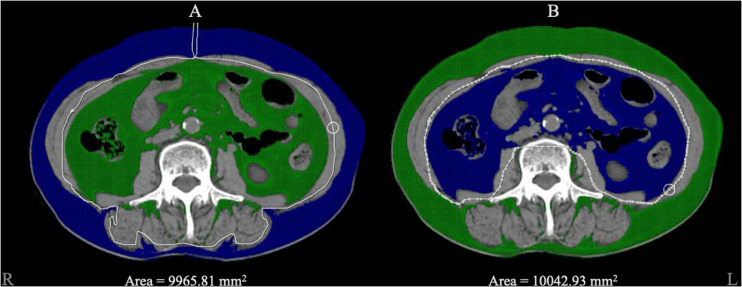
The diagram of adipose tissue segment. Blue area represented the selected zone within the CT value range from –150 to –40 Hounsfield units. (A) The blue area represented for the subcutaneous adipose tissue we circled, and 9965.81 mm2 was automatically calculated as the area. (B) The blue area represented for visceral adipose tissue and 10042.93 mm2 was automatically calculated as the area.